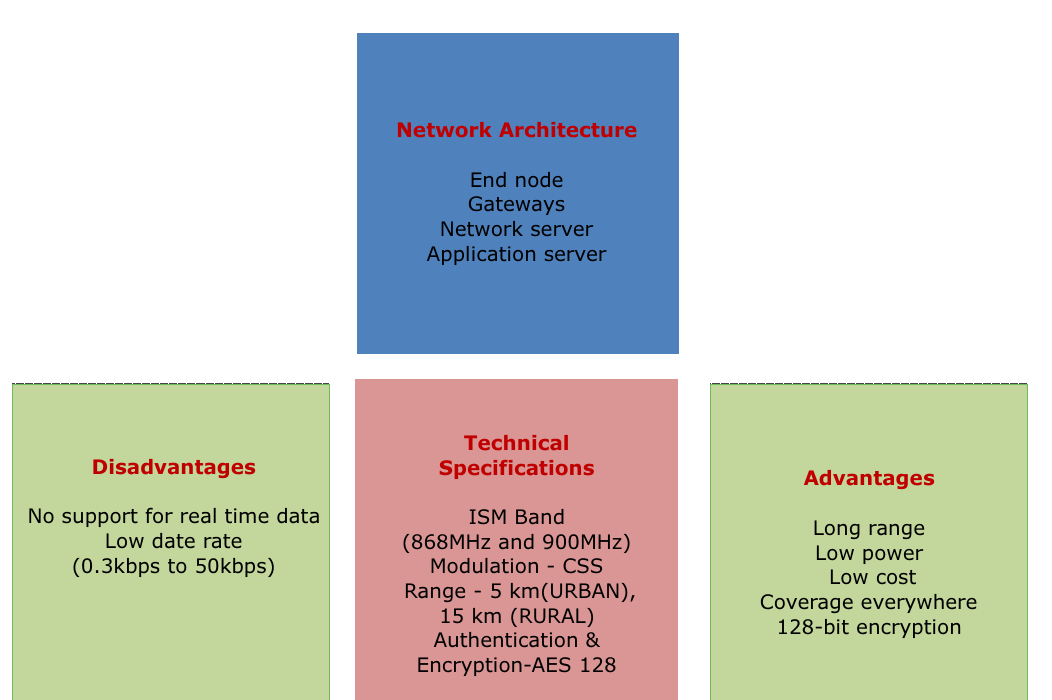
Figure 1. LoRaWAN properties, advantages and